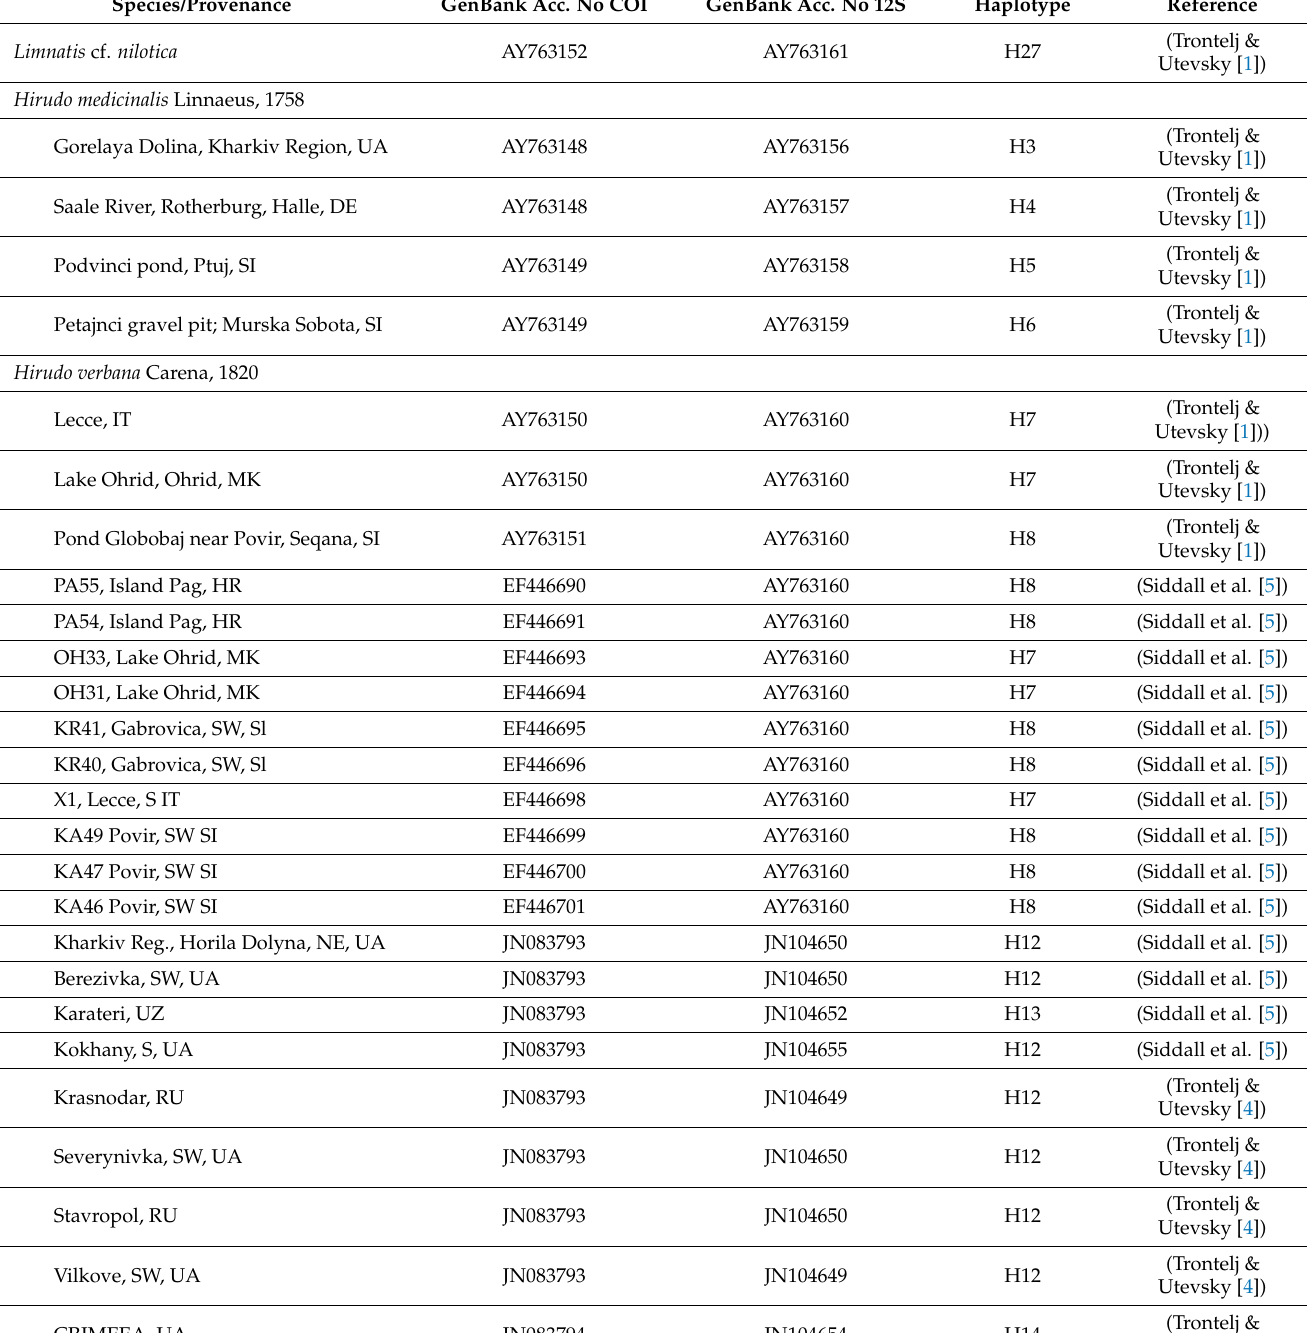
Table A1. Analysed samples with accession numbers, codes, haplotypes and